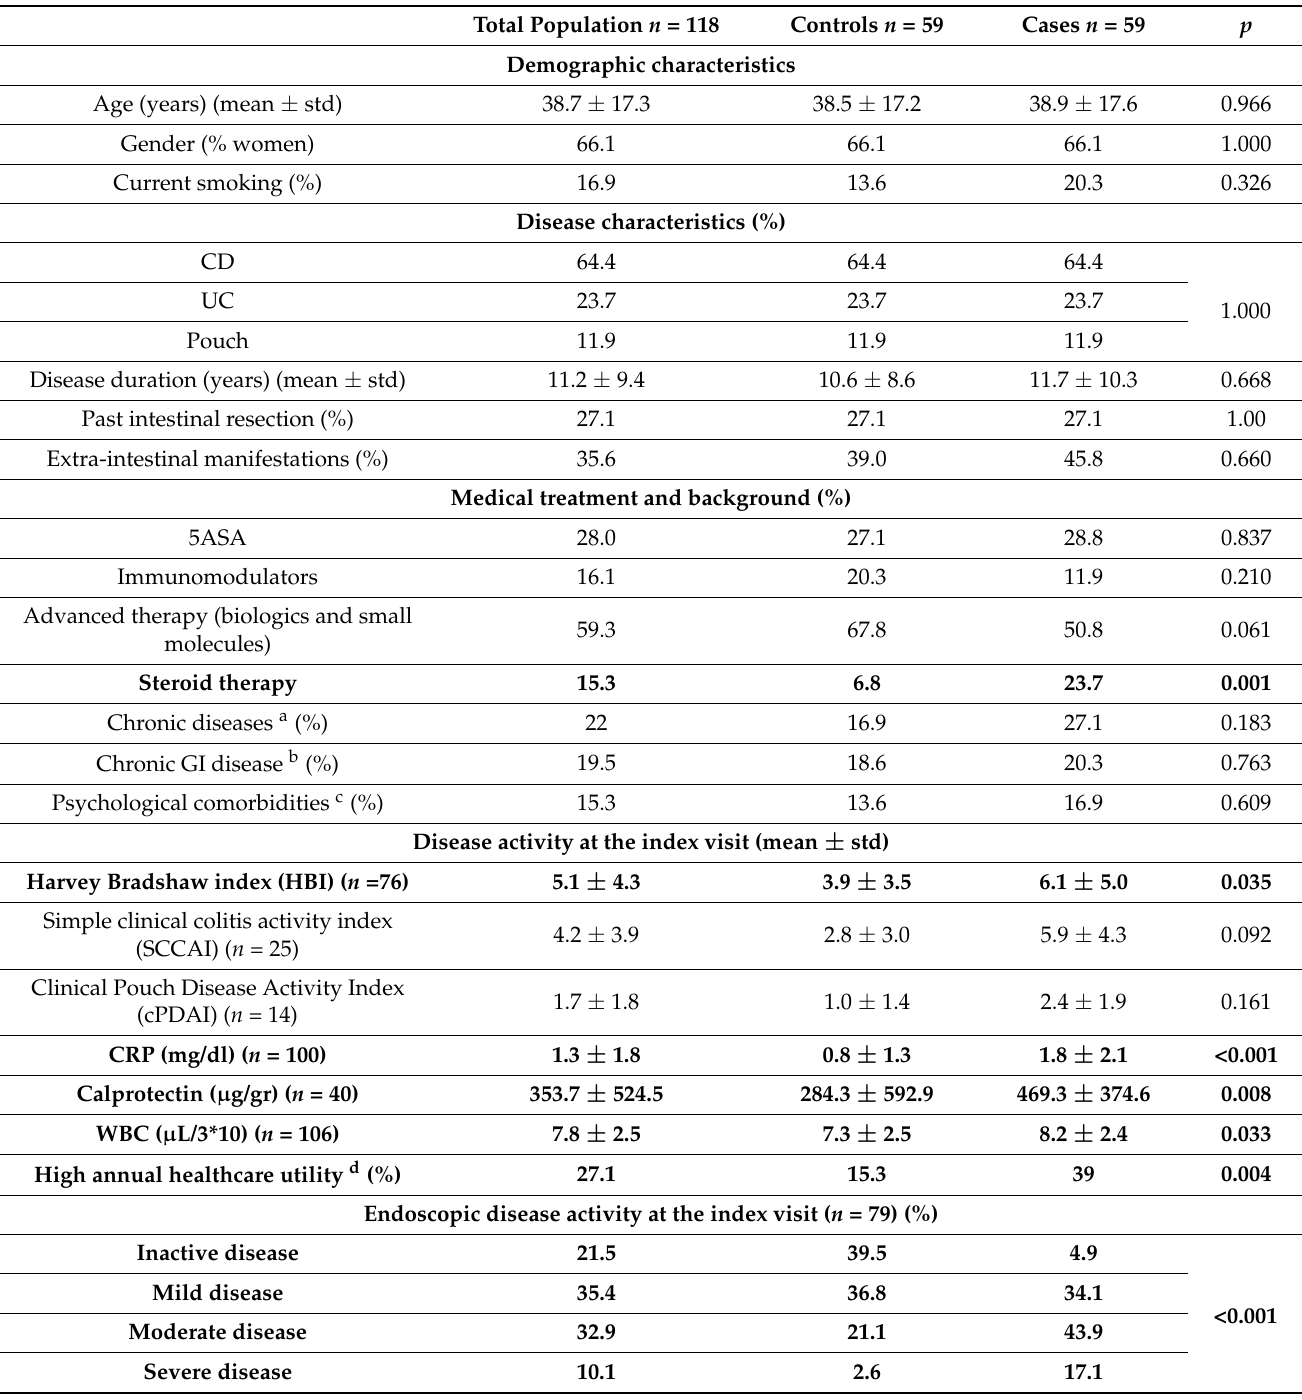
Table 1. Demographic and clinical characteristics of the study population during the index